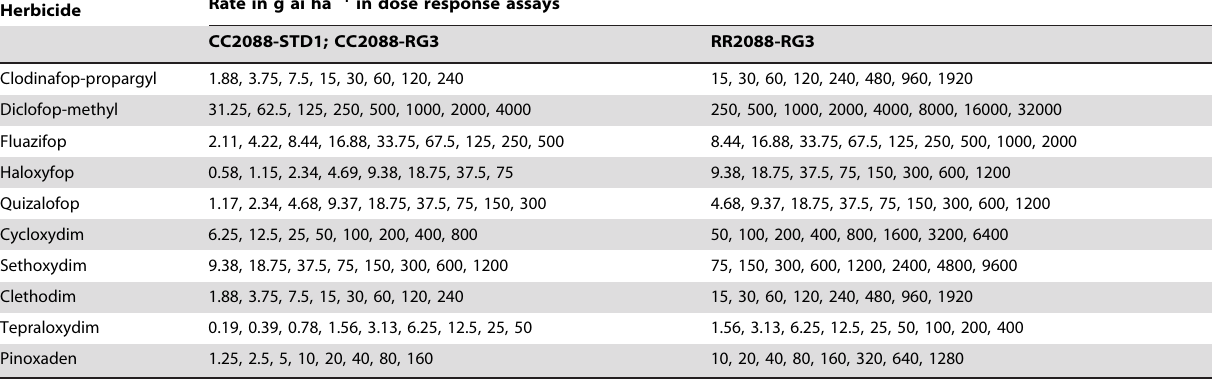
Table 1. Herbicide rates used in whole plant dose response assays.